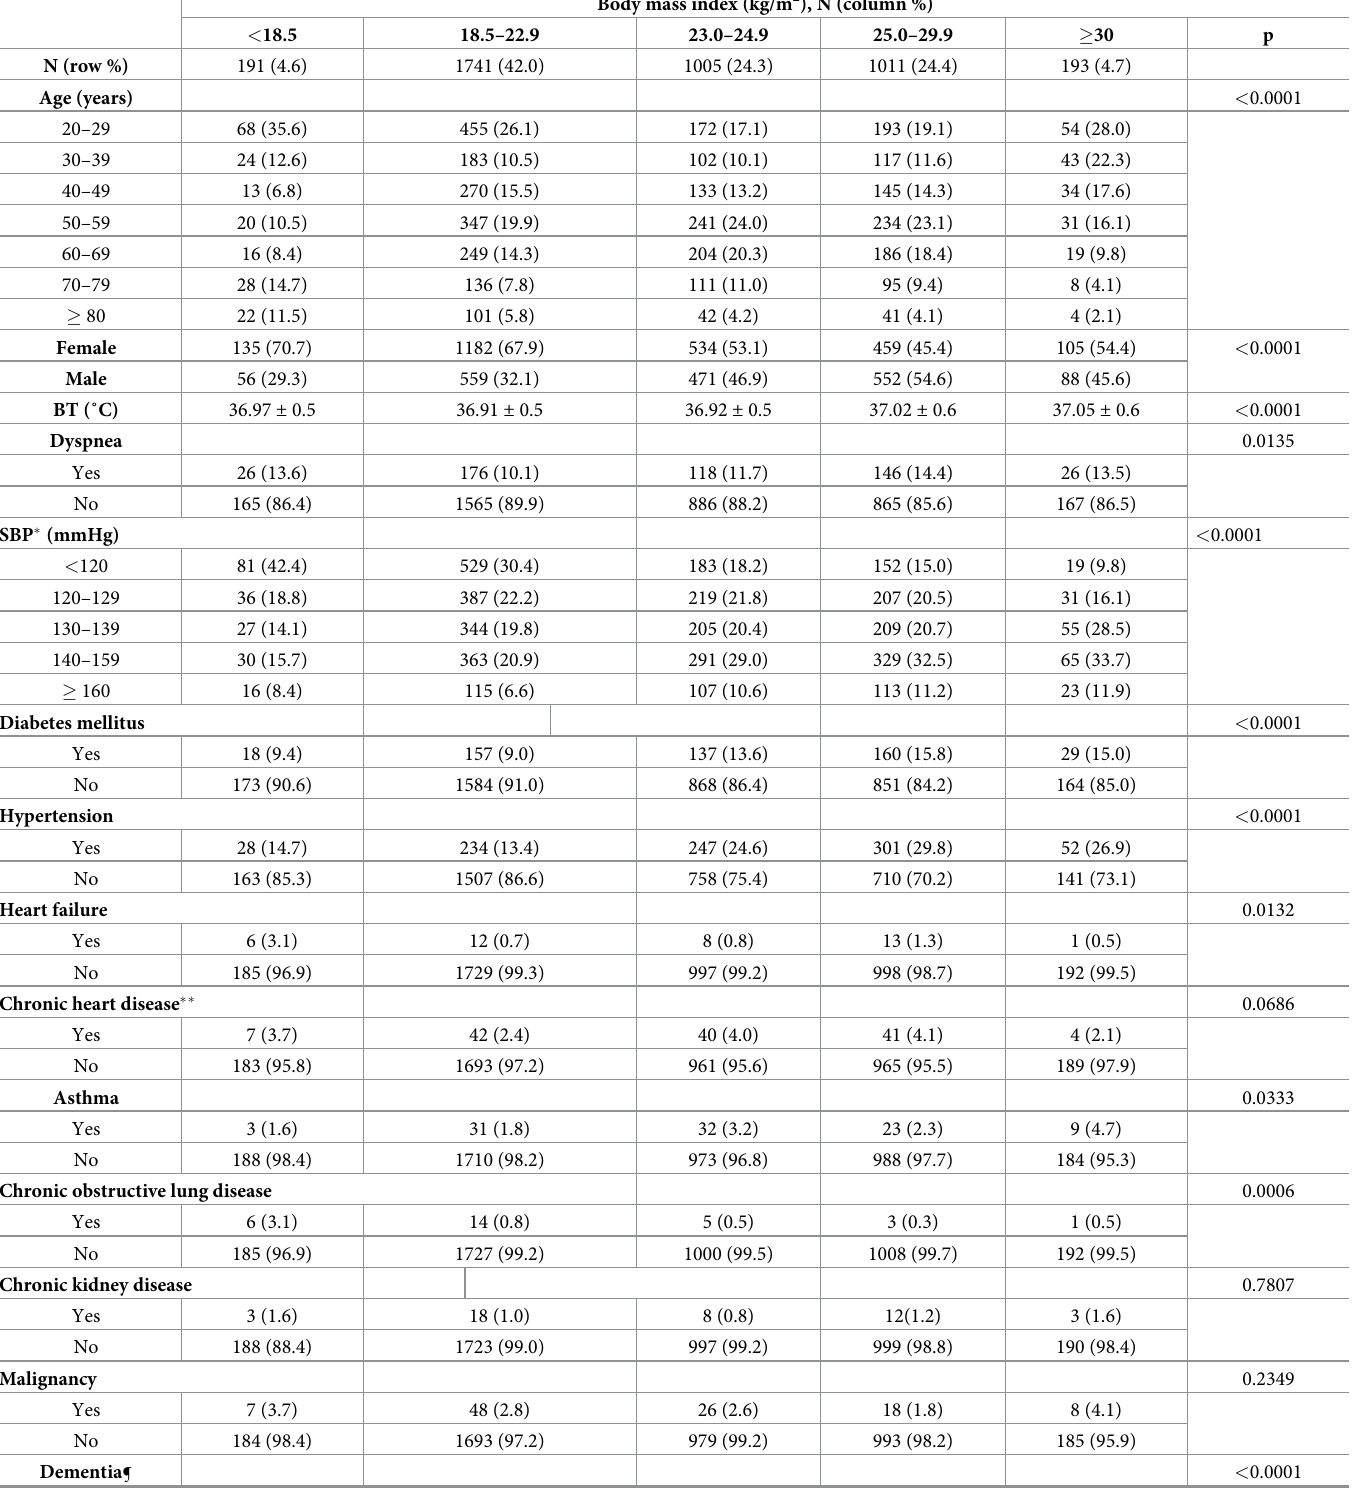
Table 1. Baseline characteristics of the study population according to the body mass